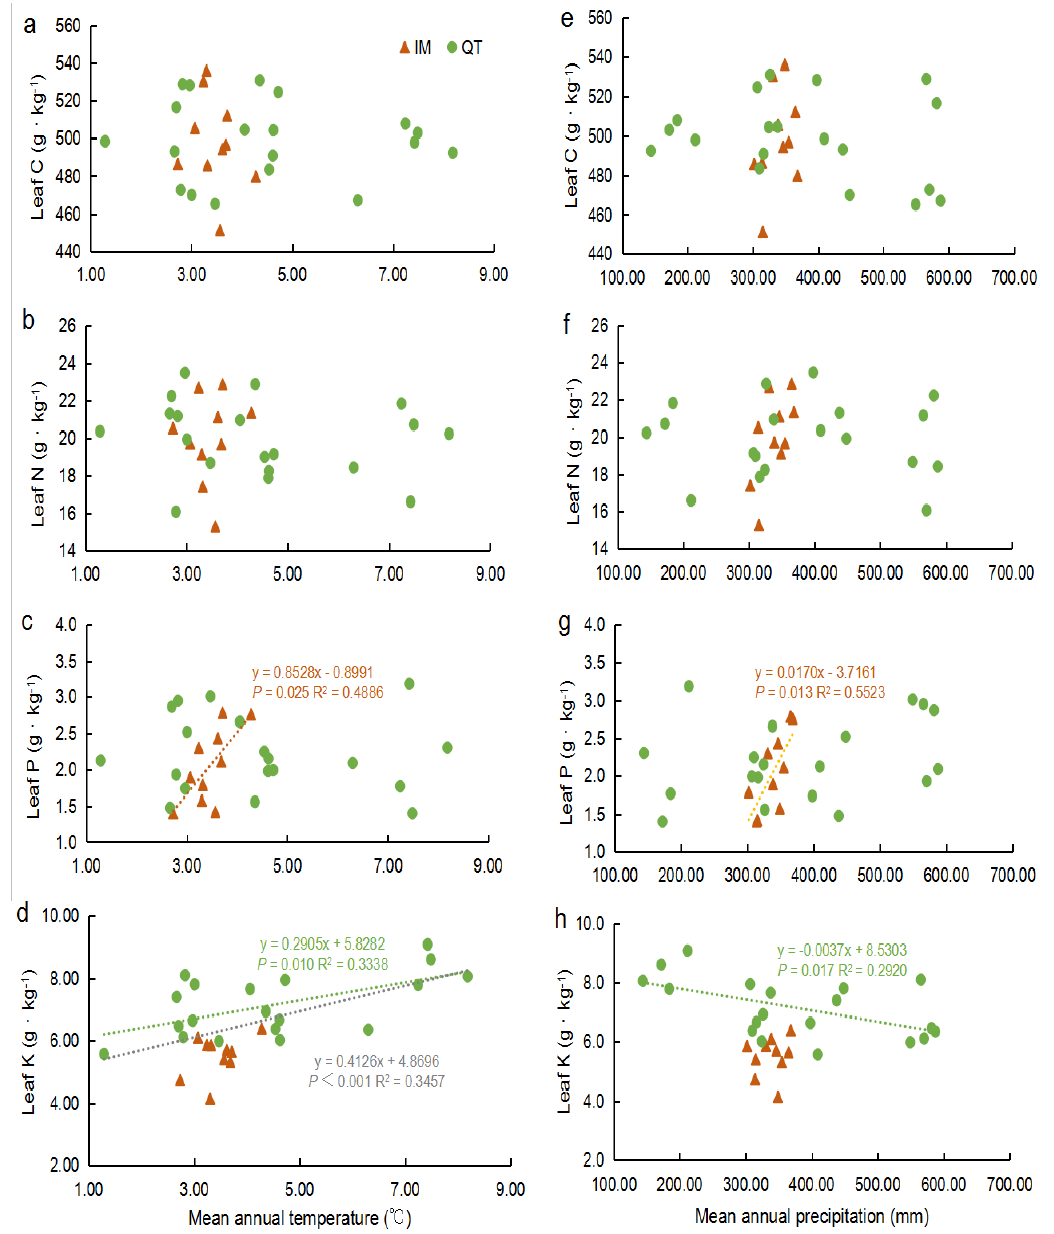
Figure 1. Relationships between the leaf C, N, P, and K content of S. chamaejasme with MAT & MAP in the Qinghai−Tibet Plateau ( green circles, n = 19) and Inner Mongolia Plateau (red triangles, n = 10). Linear regression model analyses were utilized. Colored dotted lines represented significant relationships ( p < 0.05) in different region (red, IM; green, QT; grey, all sampling sites). ( a ) MAT vs. leaf C; ( b ) MAT vs. leaf N; ( c ) MAT vs. leaf P; ( d ) MAT vs. leaf K; ( e ) MAP vs. leaf C; ( f ) MAP vs. leaf N; ( g ) MAP vs. leaf P; ( h ) MAP vs. leaf K.